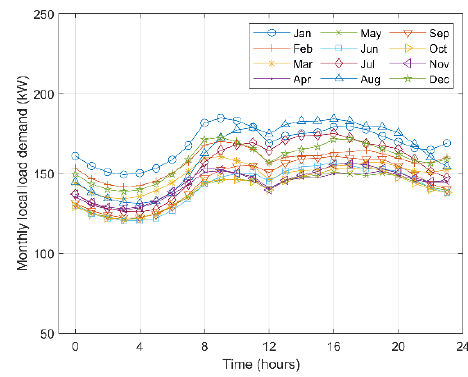
Figure 4. Local load demand of the MG.